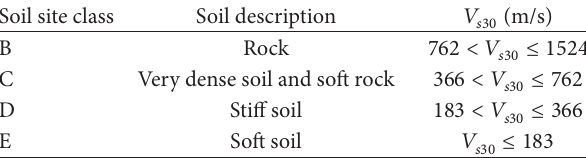
Table 1: Soil site classification according to ASCE/SEI